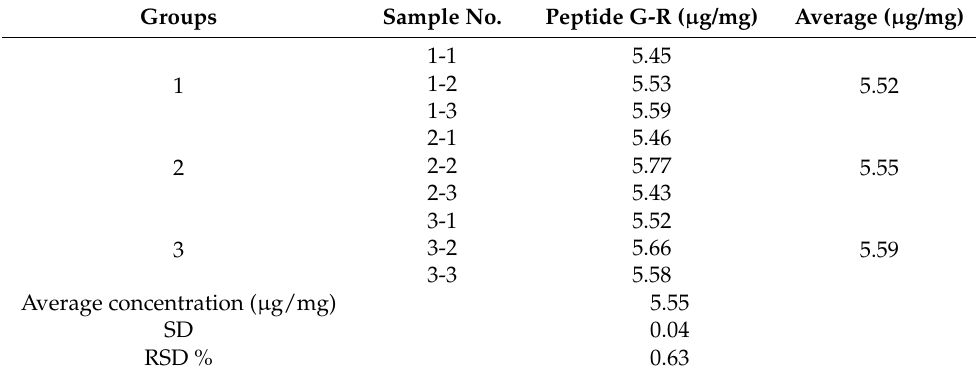
Table 3. Repeatability of quantification